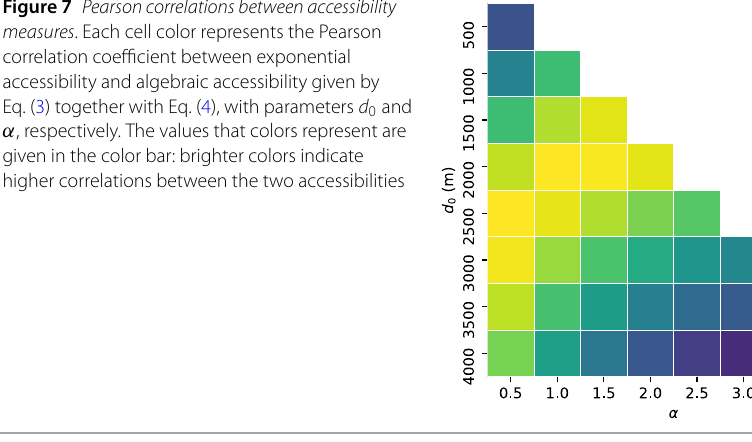
Figure 8 Spatialdistributionofexponential accessibility . The whole subway system is used when computing the accessibility measure. The characteristic distance, obtained via fitting to the daytime population, takes the value d 0 = 1796